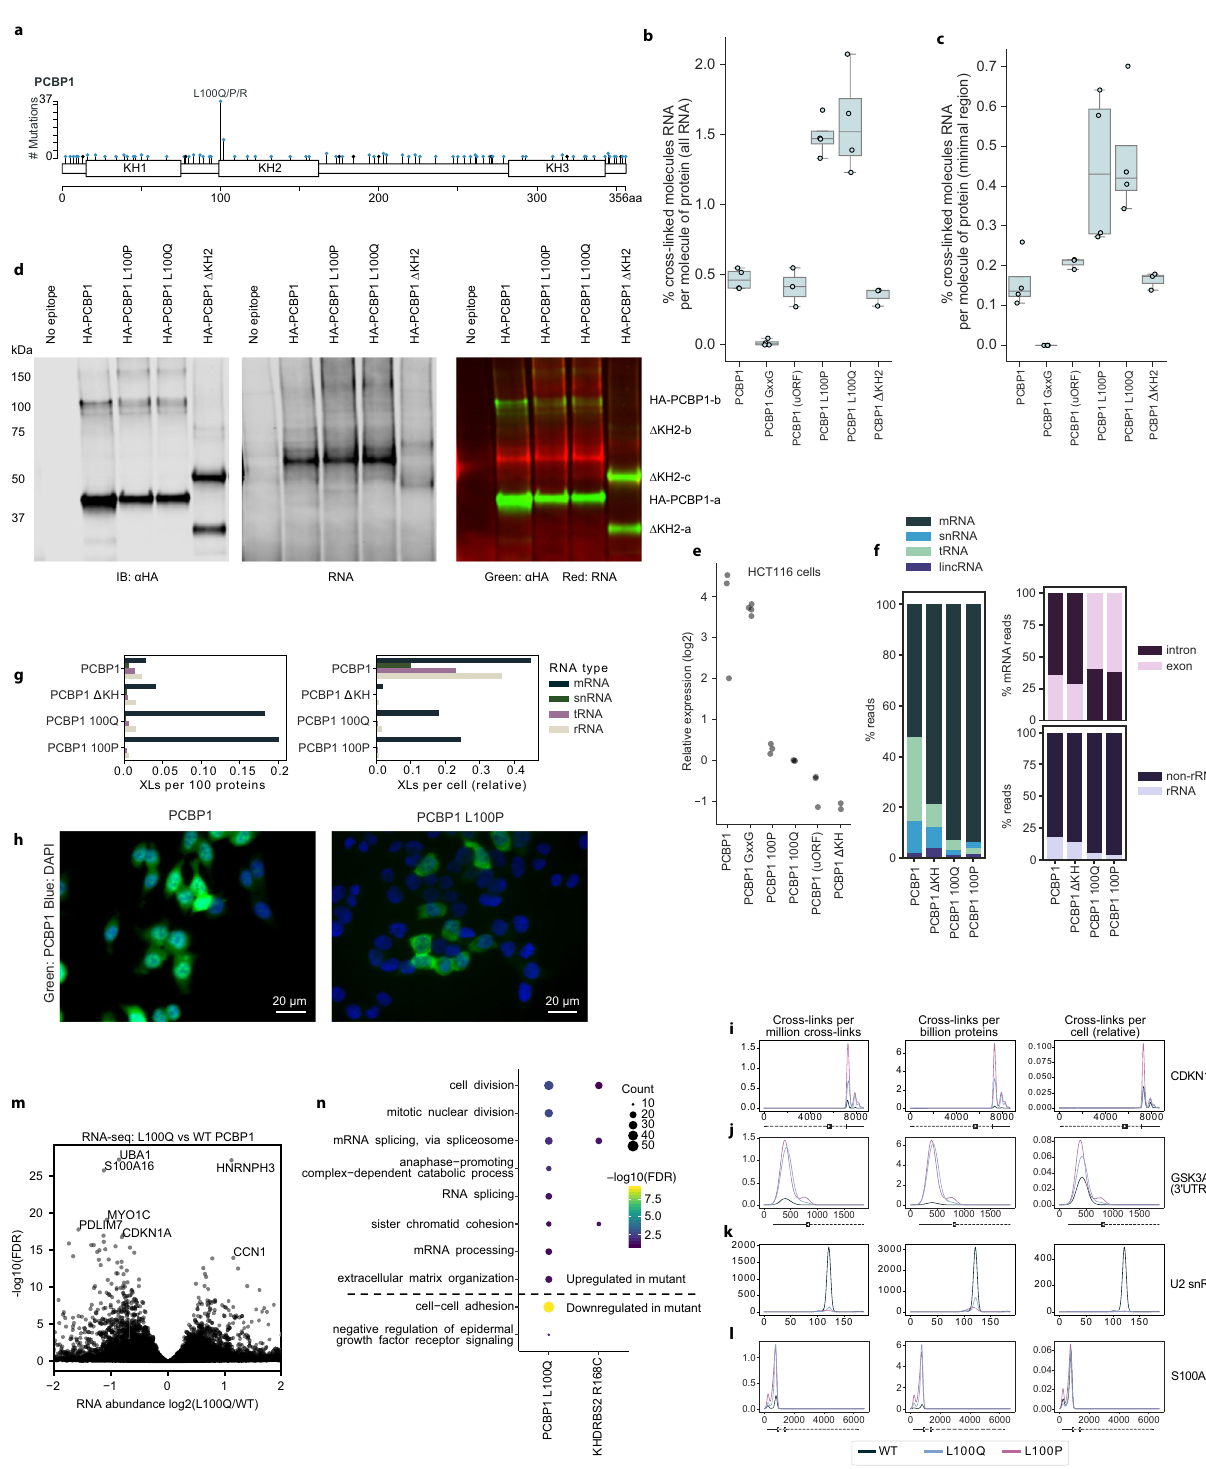
Cross-links per million cross-links